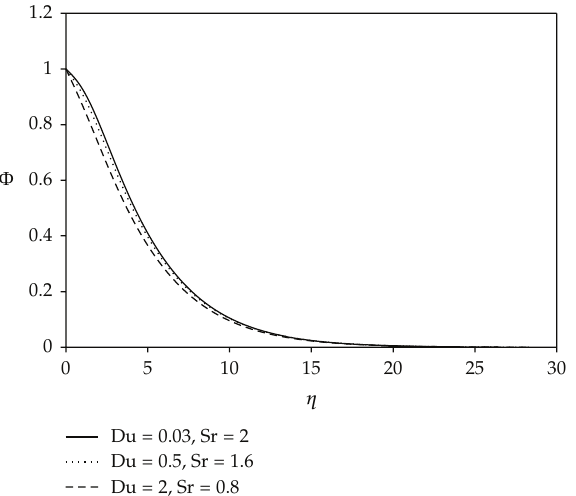
Figure 3: Concentration profile for di ff erent values of Dufour and Soret for θ r (cid:8) 5, N (cid:8) 1, Le (cid:8) 0 . 1, Pr (cid:8) 0 . 71, and Sc (cid:8) 0 .